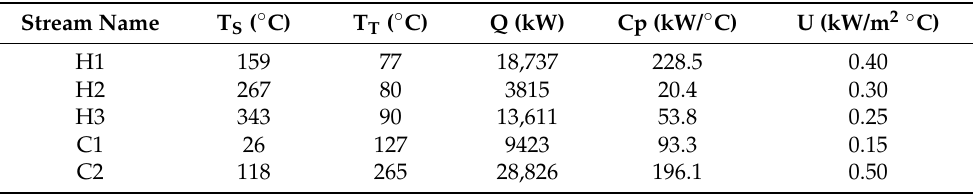
Table 2. Stream data of case study